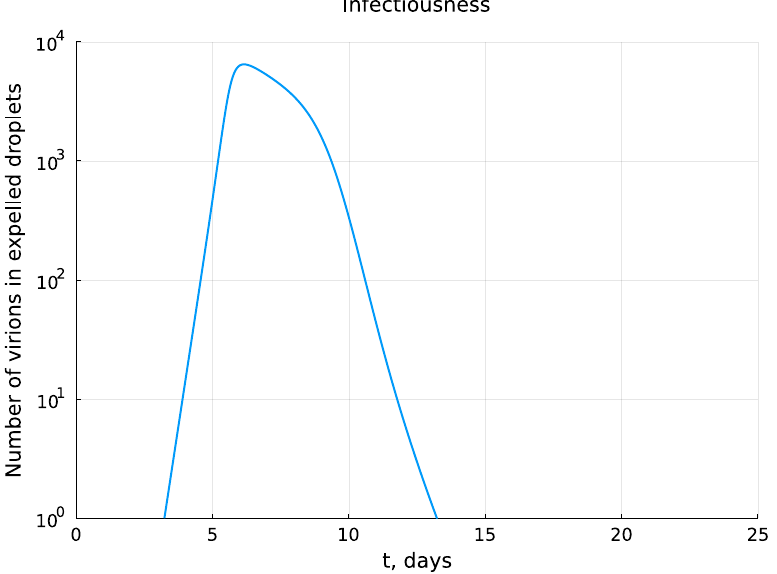
Figure 17. Kinetics of the number of virions in expelled droplets during the time course of mild-to- moderate severity infection.